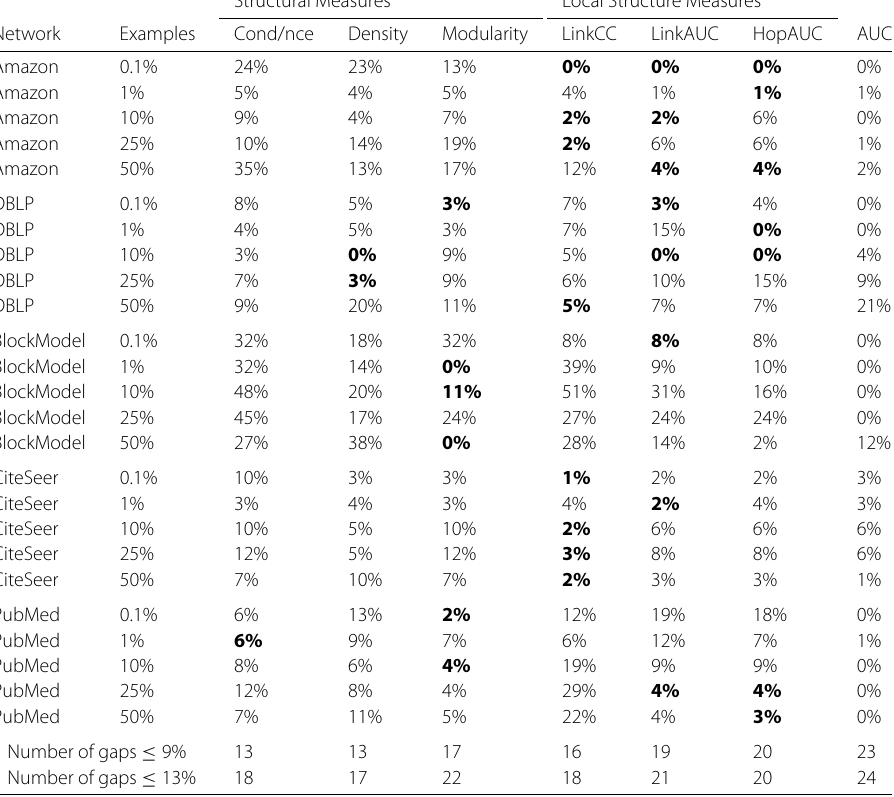
Table 6 Gap between the best NDCG value and the NDCG of the algorithm corresponding to the best measure value Structural Measures Local Structure Measures Network Examples Cond/nce Density Modularity LinkCC LinkAUC HopAUC AUC Amazon 0.1%